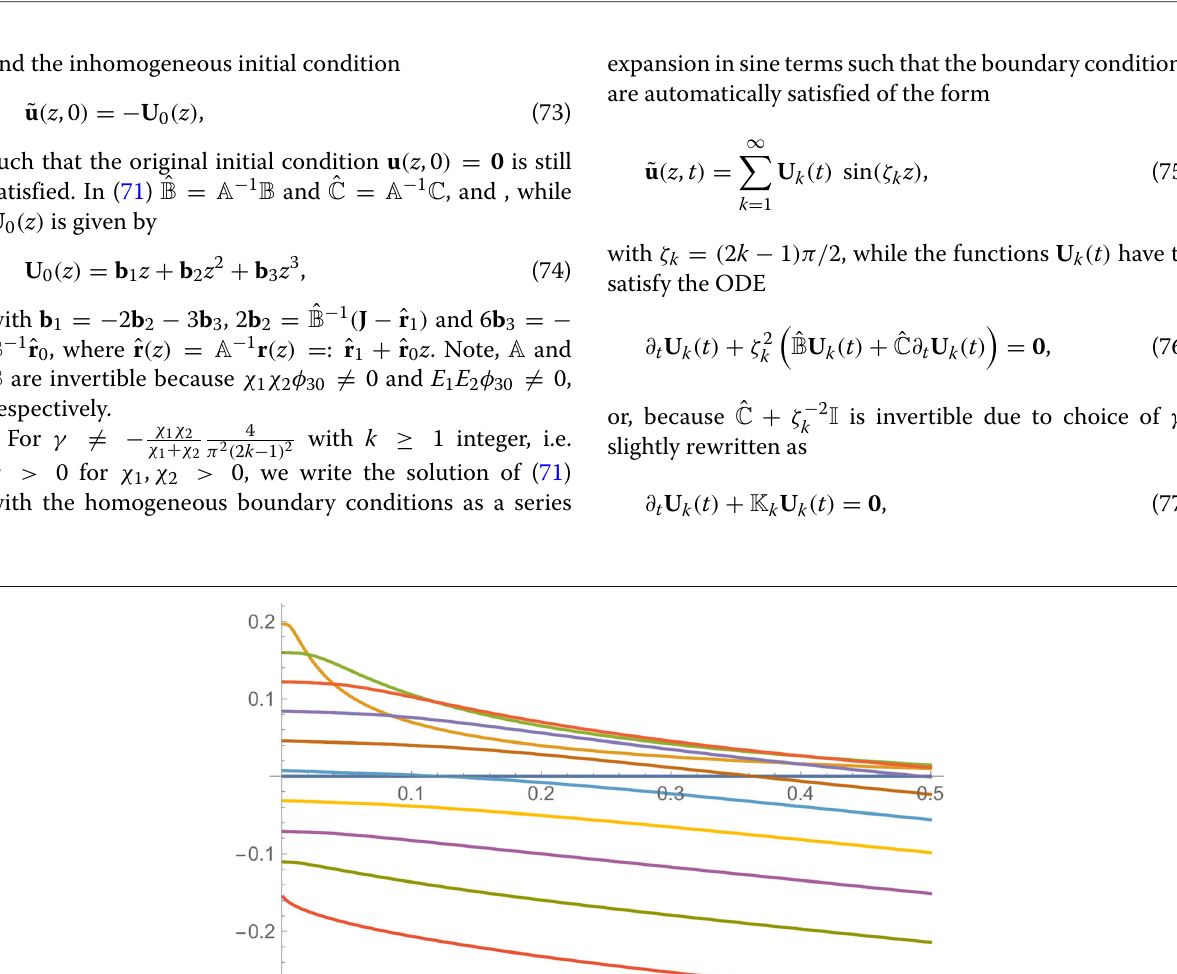
Fig. 11 Mathematica simulation of v 3 ( z , t ) with from top to bottom t ∈ { 0,0.05, ... ,0.45,0.50 } , respectively, for A 1 = A 2 = 0 and the other parameters with the values of Table 1. The oscillatons in the t = 0 graph are artifacts of the unevitable truncation of the infinite sum in Eq. (82)